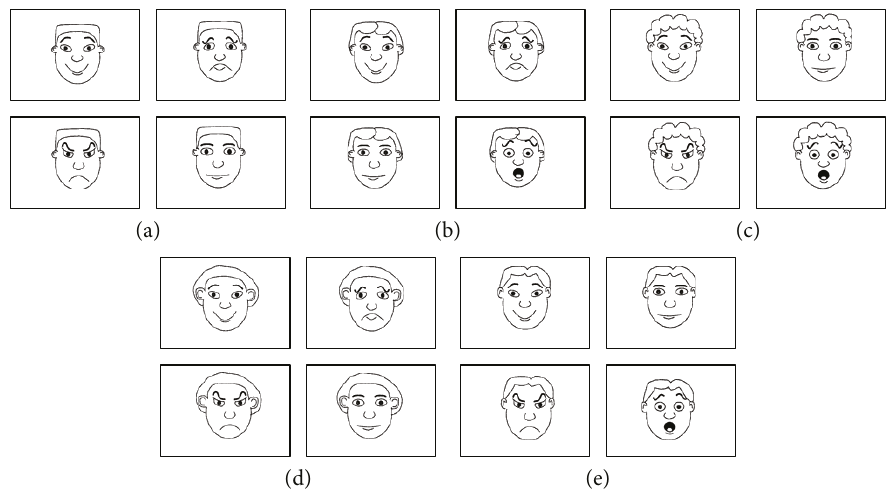
Figure 2: Example of cartoon pictures presented during TEC-1 (component I, emotion